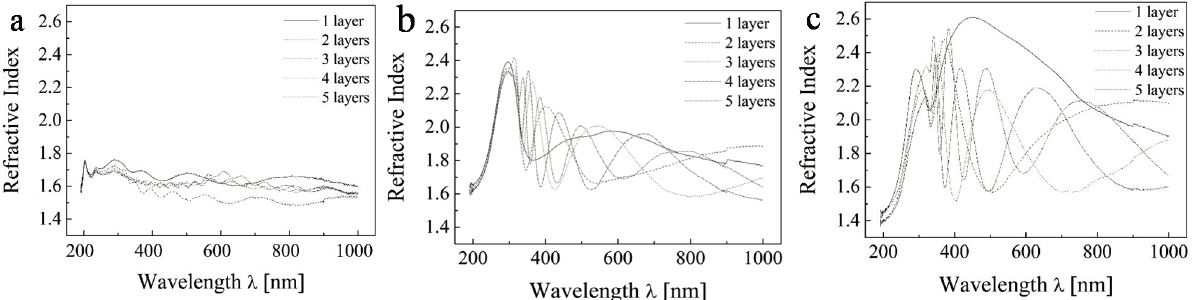
Figure 3. Ellipsometric experimental data of TiO 2 for the range 200–1000 nm for ( a ) sample A; ( b ) sample C; and ( c ) sample